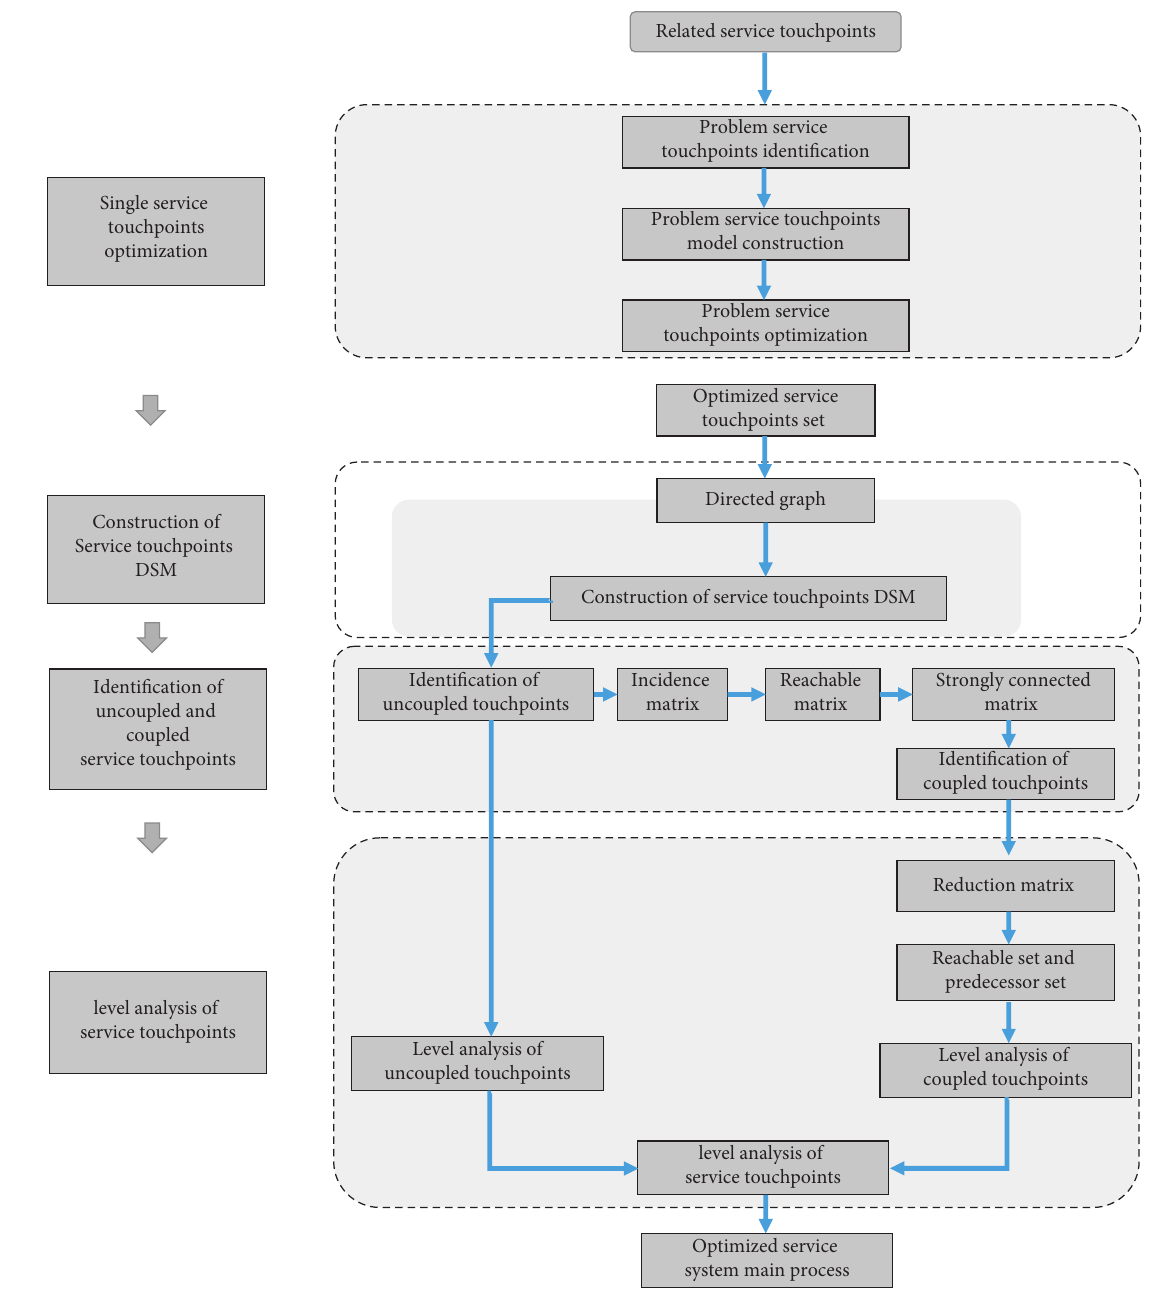
Figure 2: Service process optimization flow based on service touchpoints’ association and